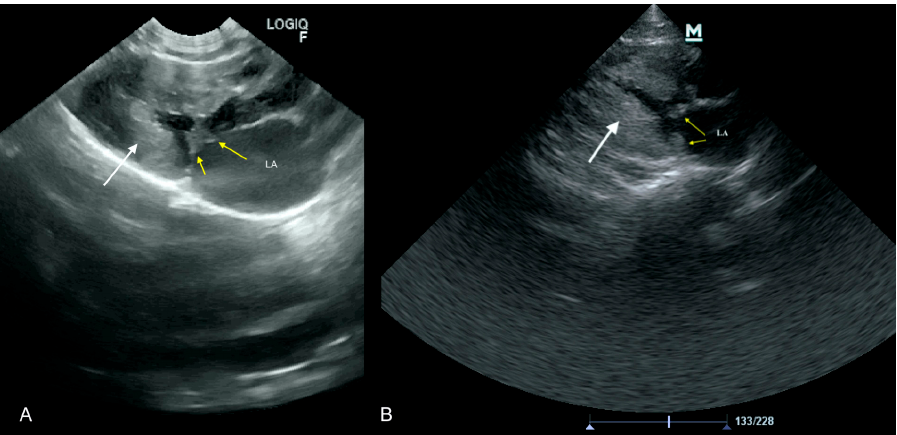
Figure 4. Yellow arrows—thickening of the mitral valve leaflets, white arrow—thickening of left ventricle free wall, LA—left atrium. ( A ) Scan from a microconvex probe obtained during focused cardiac ultrasound examination (GE Healthcare Logiq F6). ( B ) Scan from a phased array probe obtained during echocardiography examination performed by a board-certified echocardiography specialist (Mindray M7).